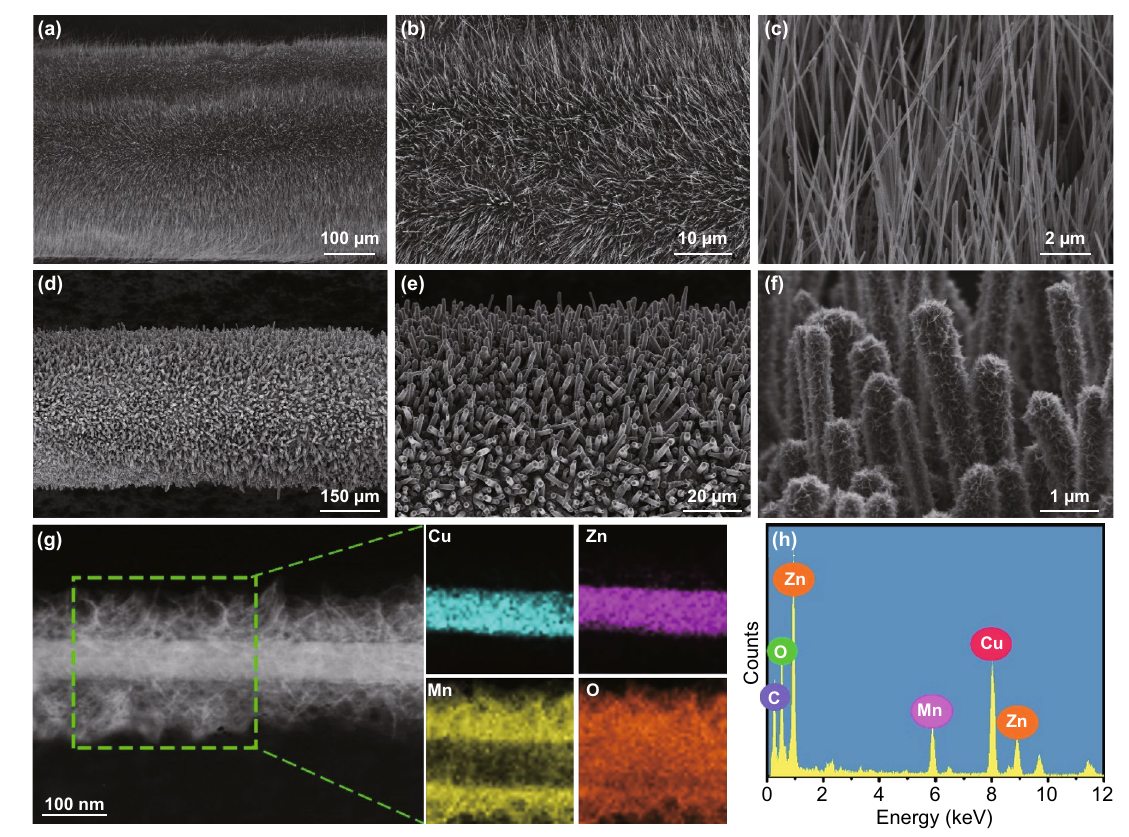
Fig. 3 a–c SEM images of CuO nanowire array grown on Cu wire at different magnifications. d–f SEM images of the MnO 2 nanosheets coat‑ ing on Zn–CuO nanowire array to form core–shell nanowire structure. g TEM image of a single Zn–CuO@MnO 2 core–shell nanowire structure and X‑ray elemental mappings of different elements of Cu, Zn, Mn, and O recorded from an individual core–shell nanowire structure. h X‑ray elemental spectrum of the